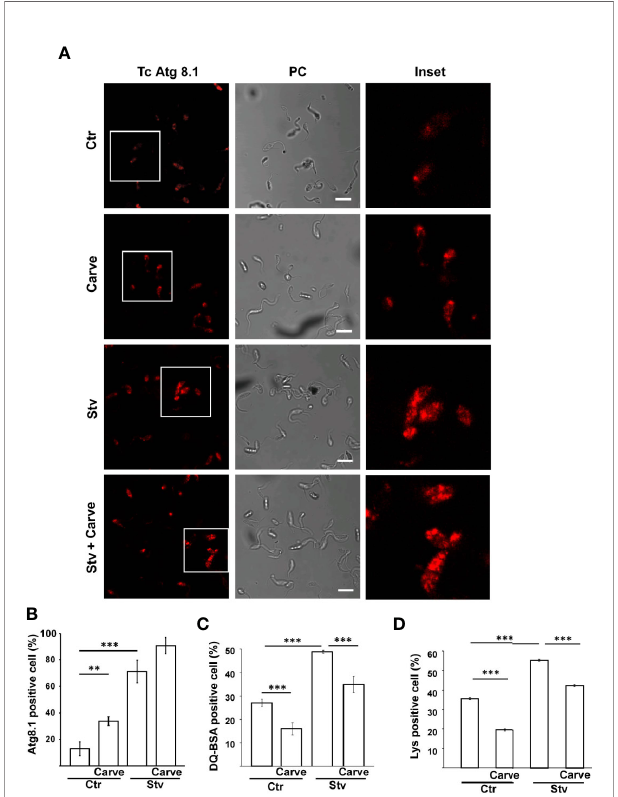
FIGURE 3 | Carvedilol is an autophagy fl ux inhibitor on T. cruzi . T. cruzi epimastigotes (Y-GFP strain) were incubated under control (Ctr) or starvation medium (Stv) in the absence (DMSO) or the presence of 10 m M carvedilol for 24 h and then processed for confocal microscopy. (A) Detection of the TcAtg8.1 protein by IIF using a speci fi c antibody. Confocal images depict autophagosomes labeled in red (TcAtg8.1) and the phase contrast (PC) for each condition. Scale bar: 10 m m. Insets show the magni fi cations delimited in the original photo. (B) Percentage of parasites with more than two Atg8.1 positive vesicles under each condition. Data shown represent the mean +/- SE from 3 independent experiments. **p < 0.01, ***p < 0.001 (Tukey test). A total of 100 parasites per group was counted. Detection of hydrolytic (C) and acidic (D) compartments were performed by incubation with DQ-BSA and Lysotracker probes respectively and analyzed by in vivo confocal studies. Graphics represent the percentage of parasites positive for DQ-BSA or Lysotracker staining in each condition. Data shown represent the mean +/- SE from 3 independent experiments. ***p < 0.001 (Tukey test). A total of 100 parasites per group was counted.